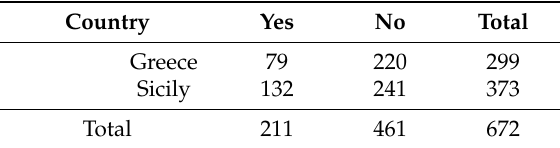
Table 6. Do you receive psychological support and/or counselling?